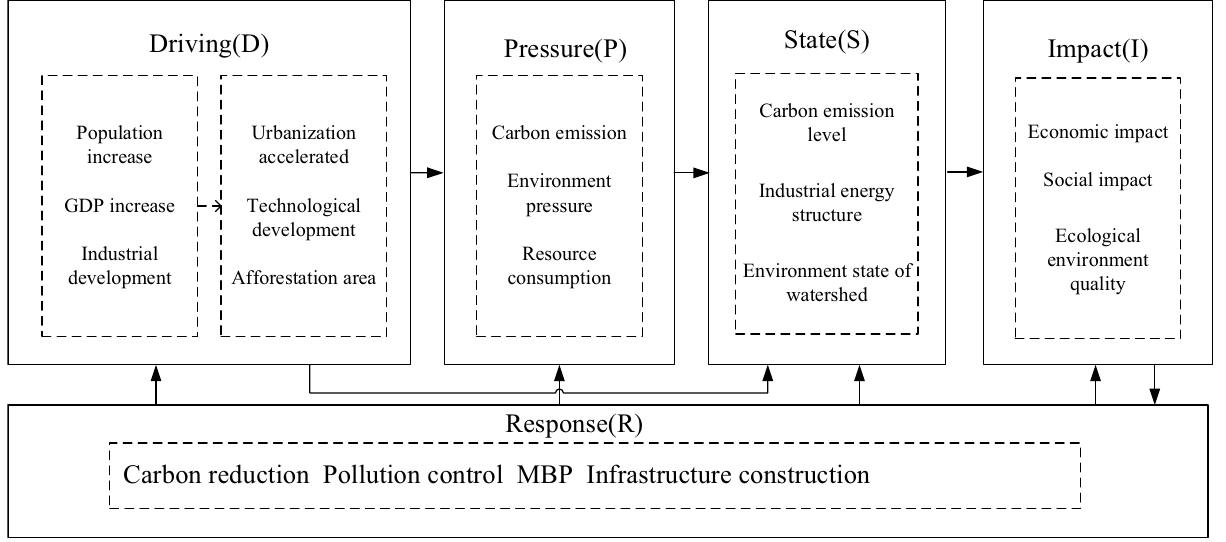
Figure 1. DPSIR model for carbon-neutral capacity evaluation in the Yellow River